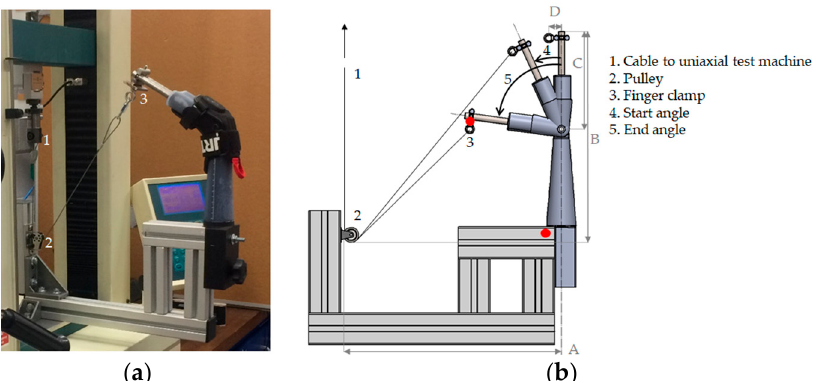
Figure 2. ( a ) Bend test setup, ( b ) schematic (A, B, C and D indicate manual measurements required for data analysis, and the two red dots indicate where markers were placed to track protector movement for video